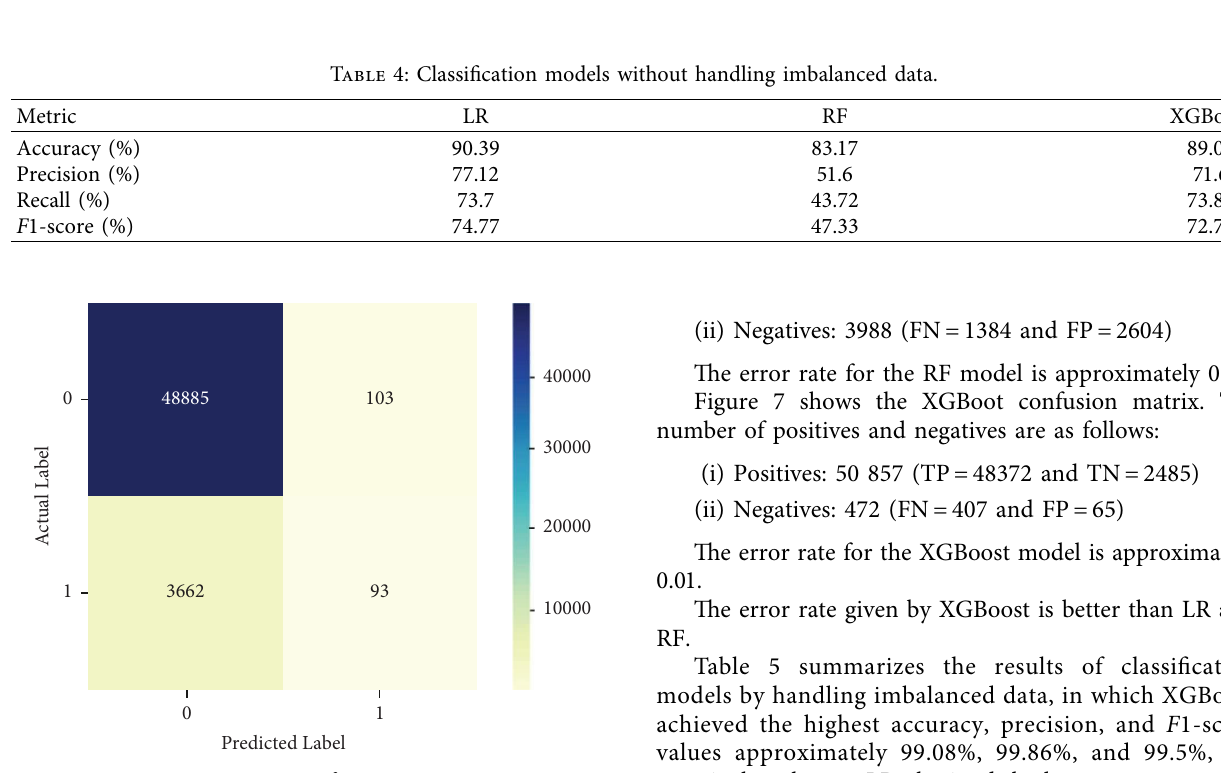
Figure 5: LR confusion